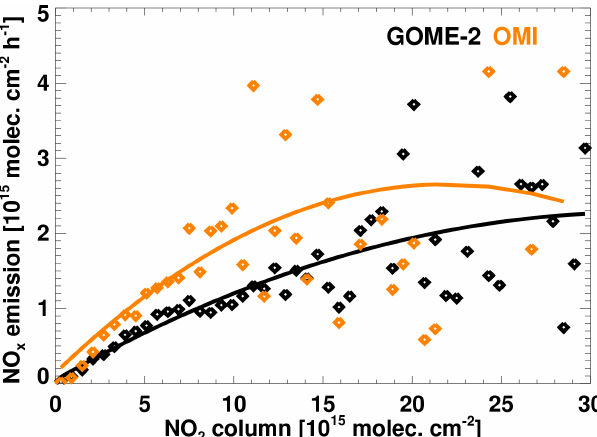
Figure 1. Simulated NO 2 column density as a function of surface NO x emission at GOME-2 (black) and OMI (yellow) overpass time over eastern China for August 2007. The dots are grid average data from REAM simulations binned by a column NO 2 interval of 6 × 10 14 molcm − 2 and the solid lines are from least-square poly- nomial regression